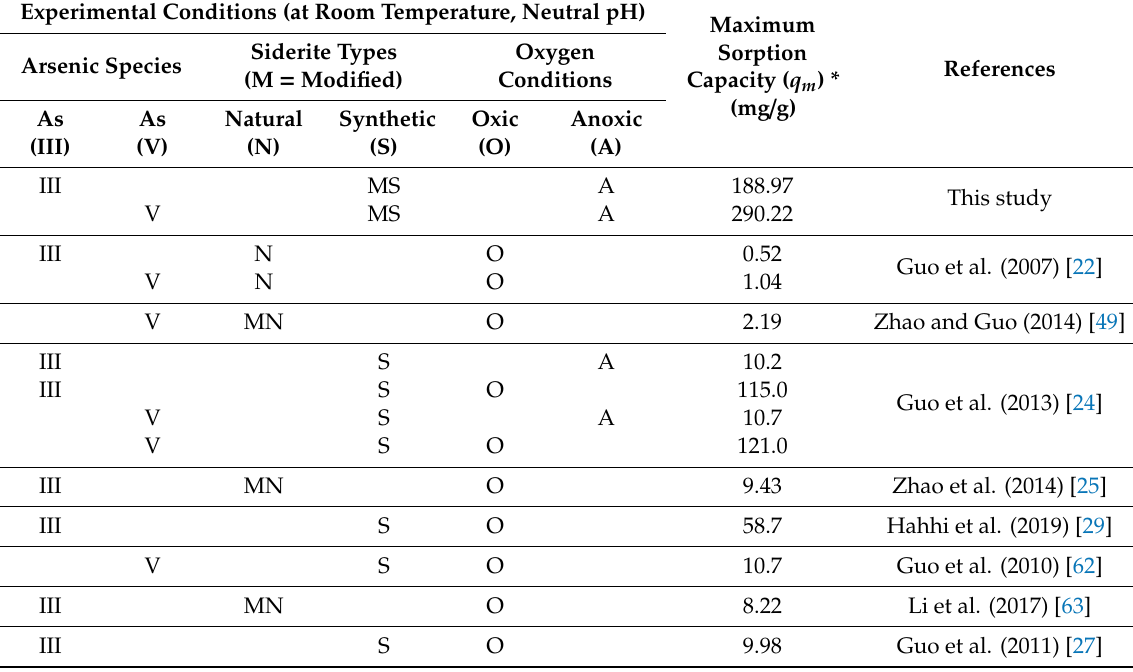
Table4. Comparisonofsorptioncapacitiesforarsenic(IIIandV)amongdi ff erentsiderite-basedsorbents. Experimental Conditions (at Room Temperature, Neutral